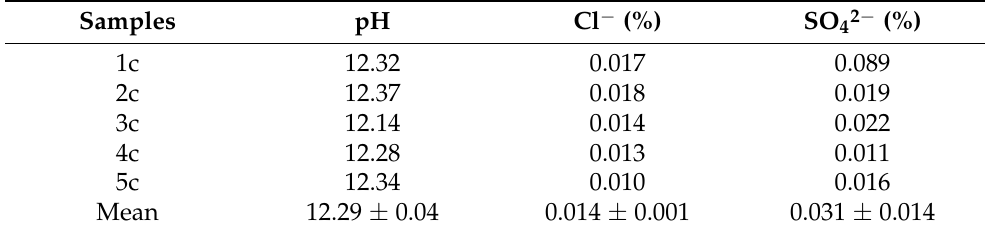
Table 6. pH values of concrete specimens and content of chloride ions and sulfate ions in concrete as a percentage of dry weight for the center layer.